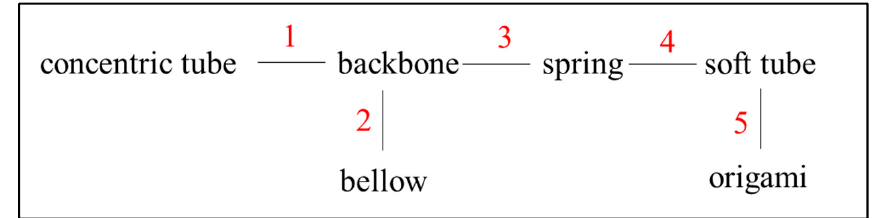
Figure 13. Combinations of different basic transmission units for the hybrid CCRs.